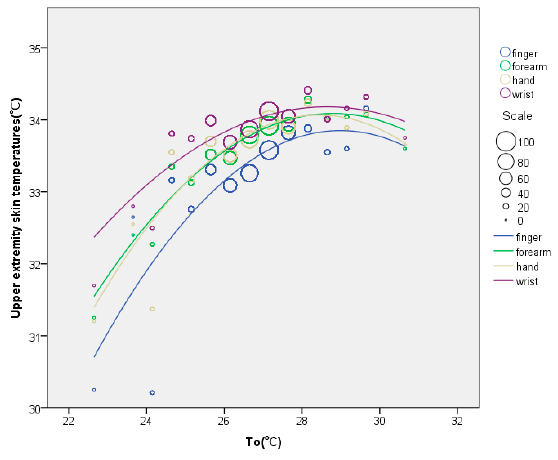
Figure 10. Relationships between T o and upper extremity skin temperatures.